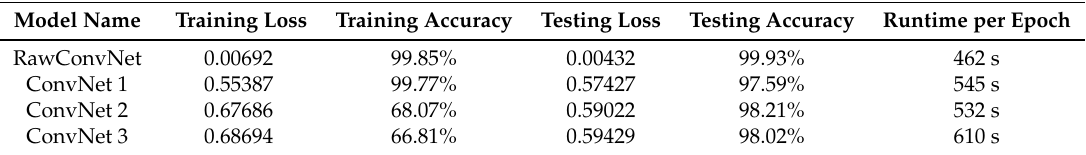
Table 4. Contribution of Custom Layer. RawConvNet is compared with ConvNets 1, 2, and 3 after 100 epochs of training with a 70–30 train/test split of the BUZZ1 train/test dataset. The receptive field size n is set to 80 for all